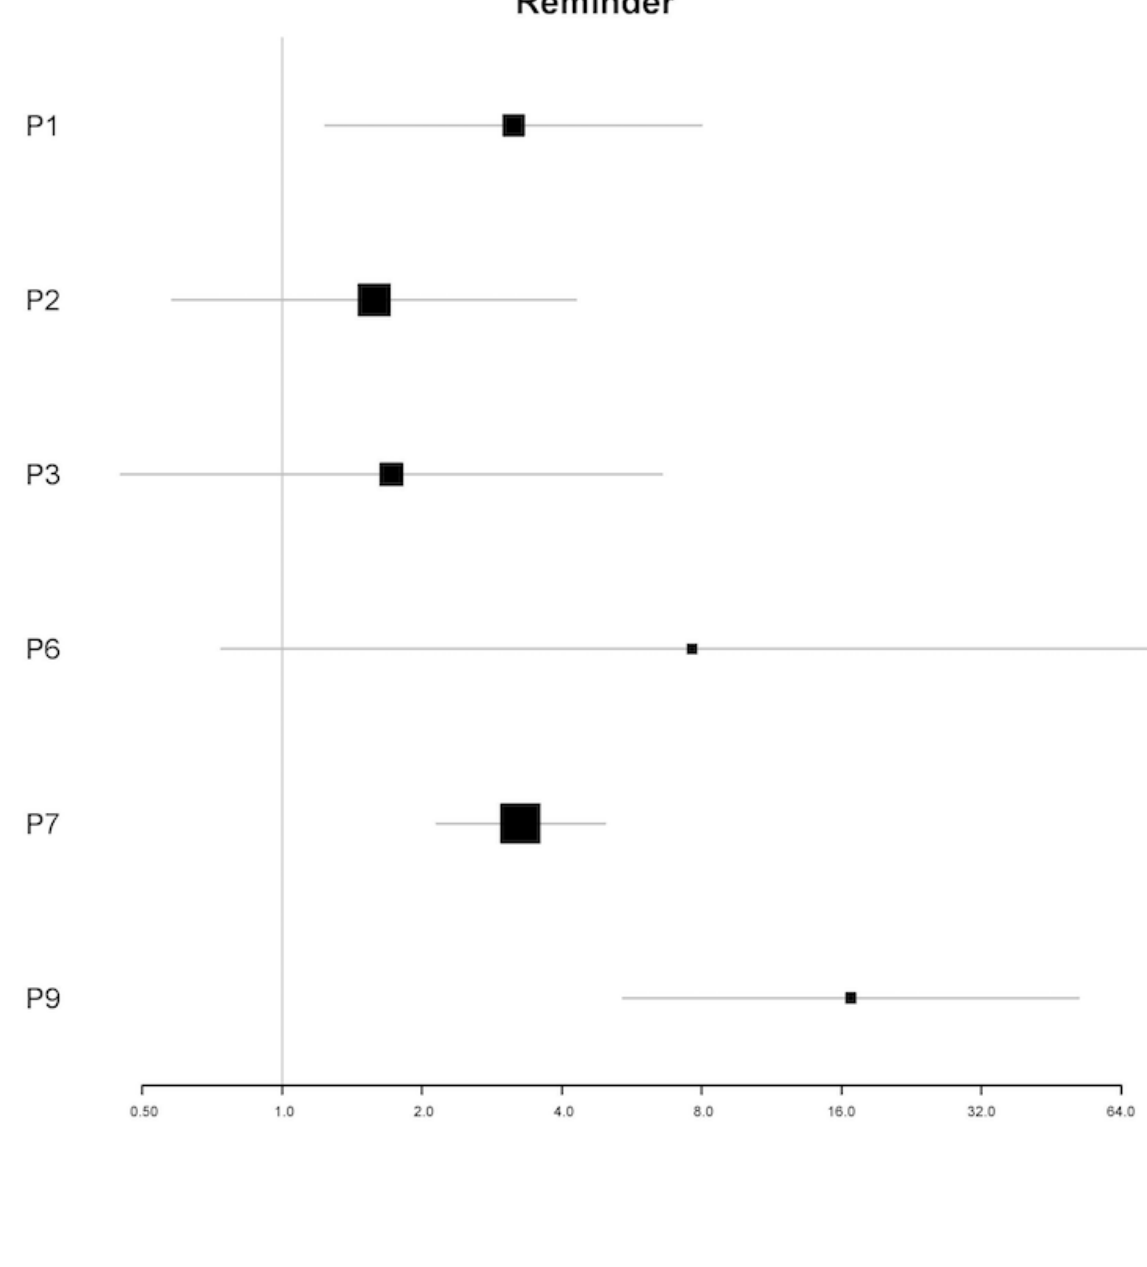
Figure 1. Plot of incidence rate ratios and 95% CIs (x-axis) for the association of the daily reminder and the frequency of engagement for each participant (y-axis) in univariable analyses. The vertical line indicates parity; 95% CIs that cross the line of parity indicate nonsignificant incidence rate ratios. For P4, the univariable model did not converge. P4 is hence not included in this plot. P: